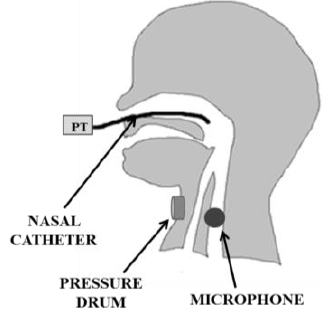
Figure 8. Different devices used for swallowing monitoring: PT connected to a transnasal catheter; pressure drum applied on the hyoid bone; microphone applied on the